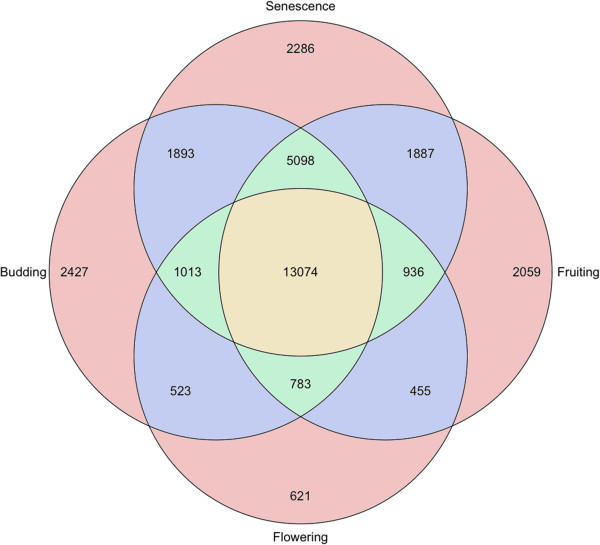
Venn diagram of transcript abundance across development. The 7 developmental stages sampled were grouped into four categories for a simplified comparison of transcript abundance: Budding – stages 1 & 2; Flowering – stage 3; Fruiting – stages 4 & 5; Senescence – stages 6 & 7. RPKM values for transcript expression in each developmental category were used to establish transcript presence or absence and results compared.